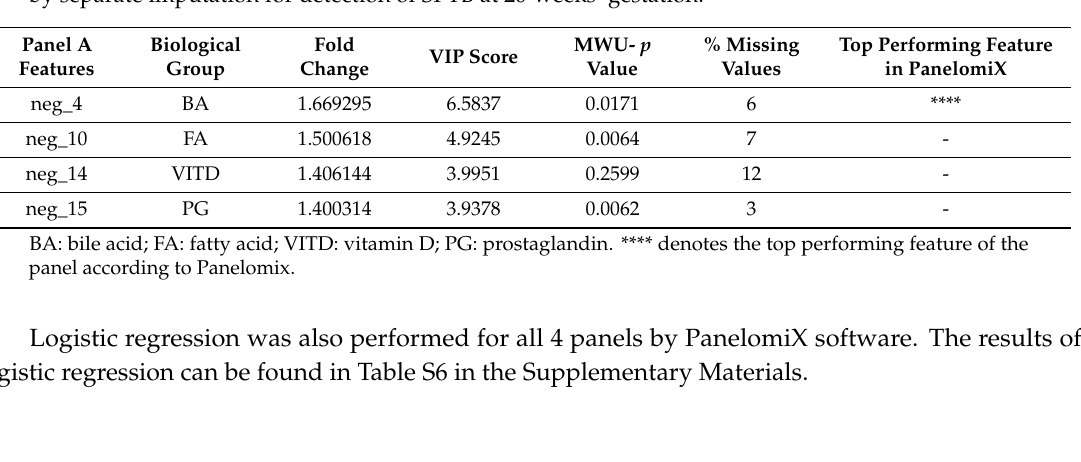
Table 4. Table of features of the top performing panel found by FC and PLSDA / VIP ranking preceded by separate imputation for detection of SPTB at 20-weeks’